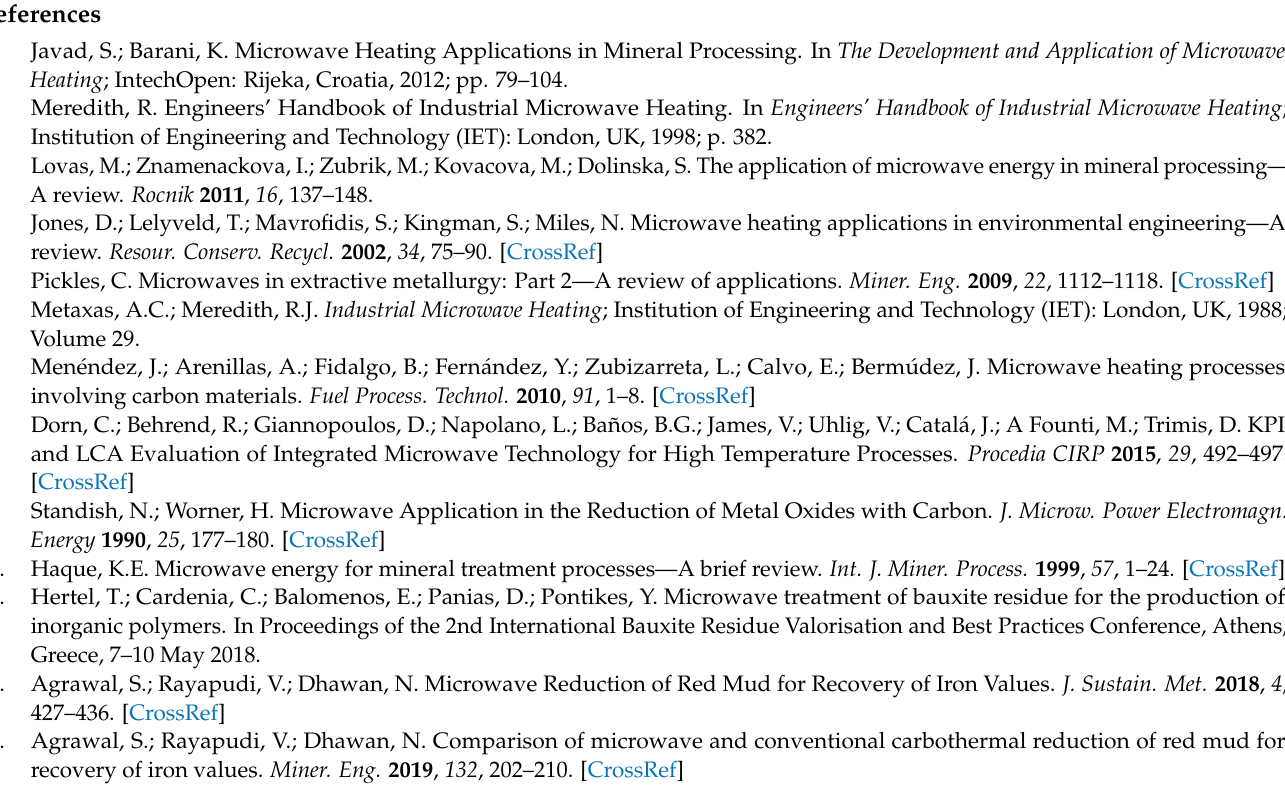
Figure A2. XRD Comparison between BR, MBR, cinder after 1st microwave roasting reduction and cinder after 2nd microwave roasting reduction.